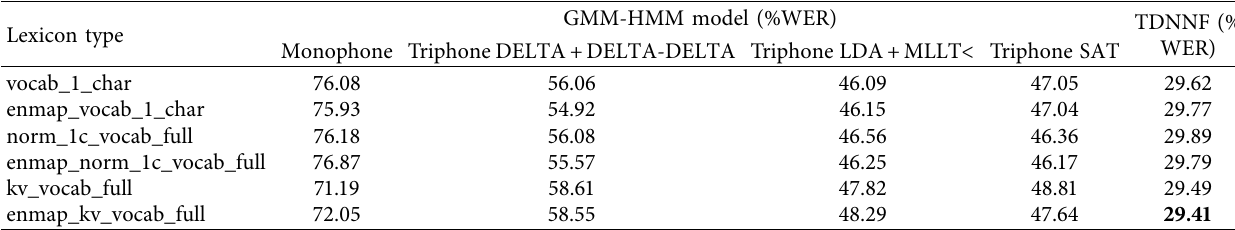
Table 6: The performance of the acoustic models using the unvalidated dataset.